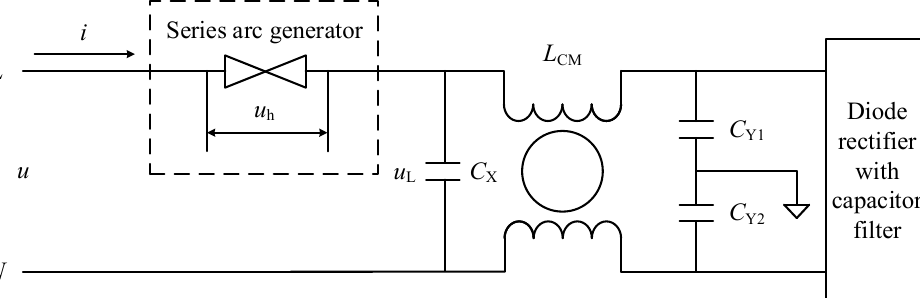
Figure 6. Test circuit of diode rectifier with capacitive filter and EMI filter.